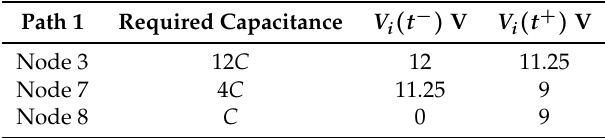
Table 3. Use of unequivalent voltage differences for the nodes of Path 1: 3-7-8 when the capacitance of Node 7 is insufficient.